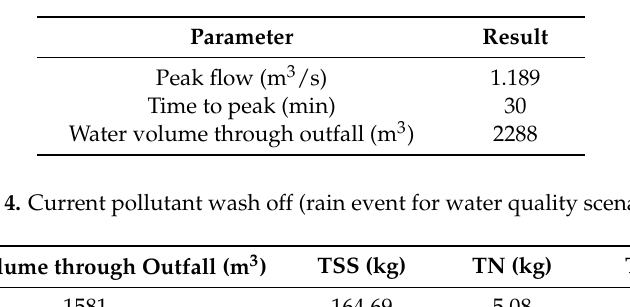
Figure 2. Rain event for peak flow control ( left ) and water quality control ( right ). Table 3. Current conditions for peak flow control scenario.